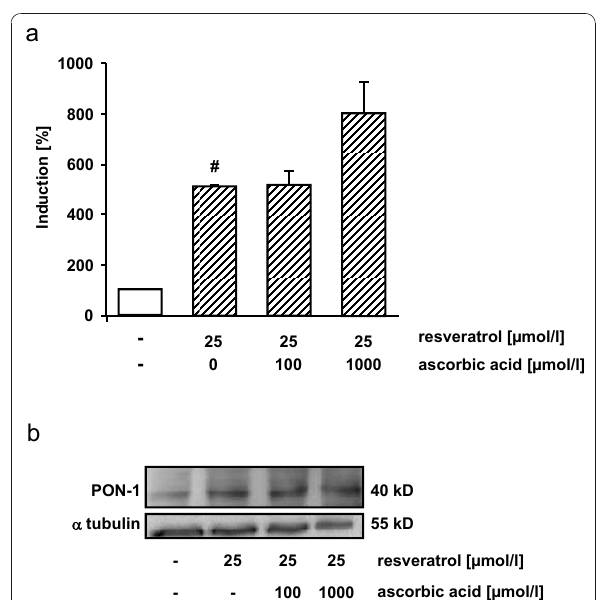
Figure 5 Effects of resveratrol and ascorbic acid on PON1 transactivation and PON1 protein levels . PON1 transactivation in HUH7/PON1 cells supplemented with resveratrol in the absence and presence of 100 and 1000 μ mol/l ascorbic acid (a). Protein levels of PON1 in HUH7 cells in response to resveratrol supplementation in the absence and presence of 100 and 1000 μ mol/l ascorbic acid (b). Data are mean ± SEM of at least 2 experiments performed in triplicate. # indicates significant difference between control and 25 μ mol/l resveratrol p < 0.05, Mann-Whitney-U-Test;